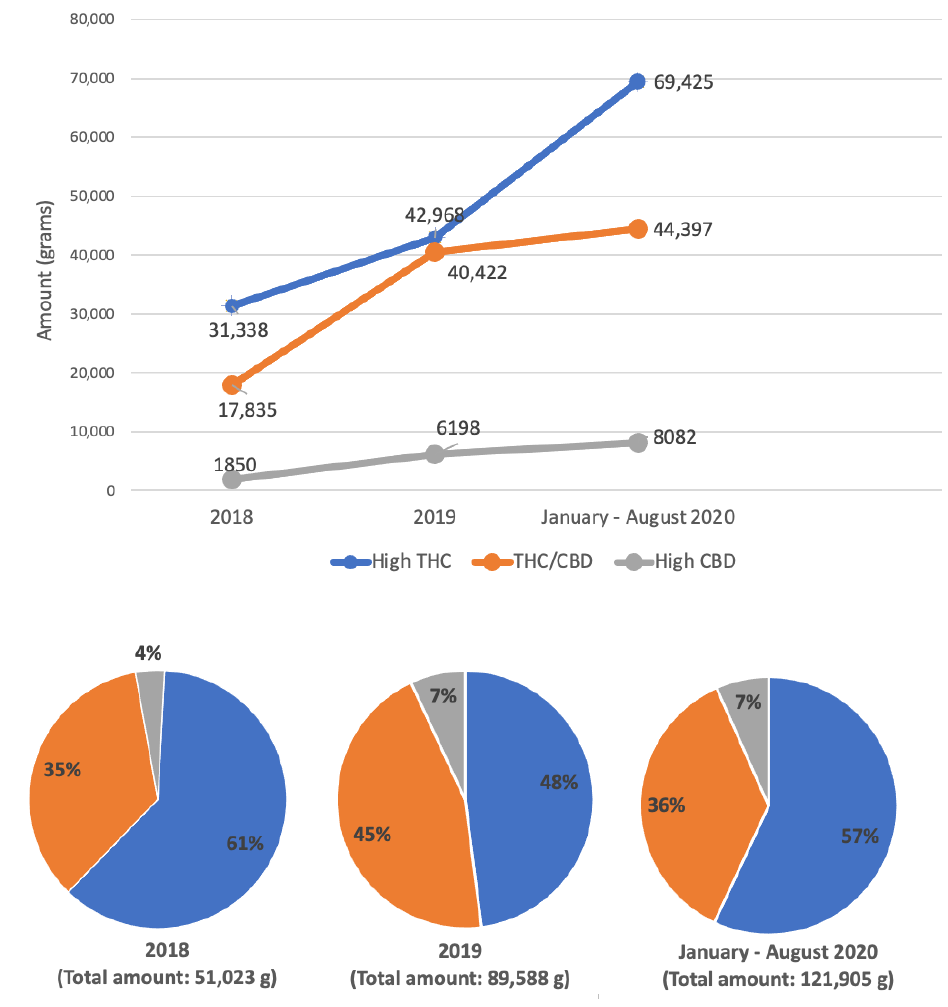
Figure 1. Regional summary: amount of purchased cannabis (in grams) and percentage distribution of different product types.